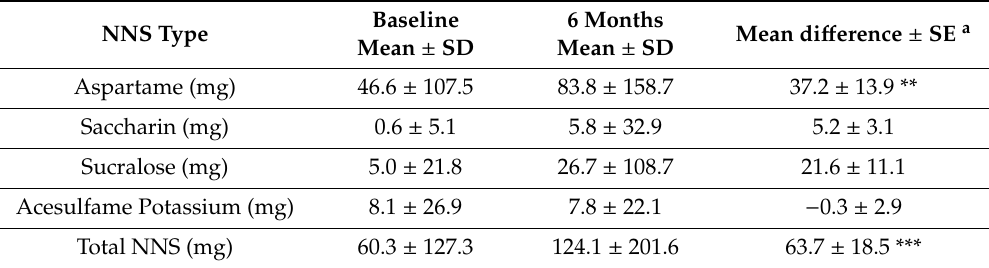
Table 2. Changes in mean daily non-nutritive sweetener (NNS) mg consumption in SIPsmartER participants by NNS type and total NNS over a 6-month sugar-sweetened beverage reduction